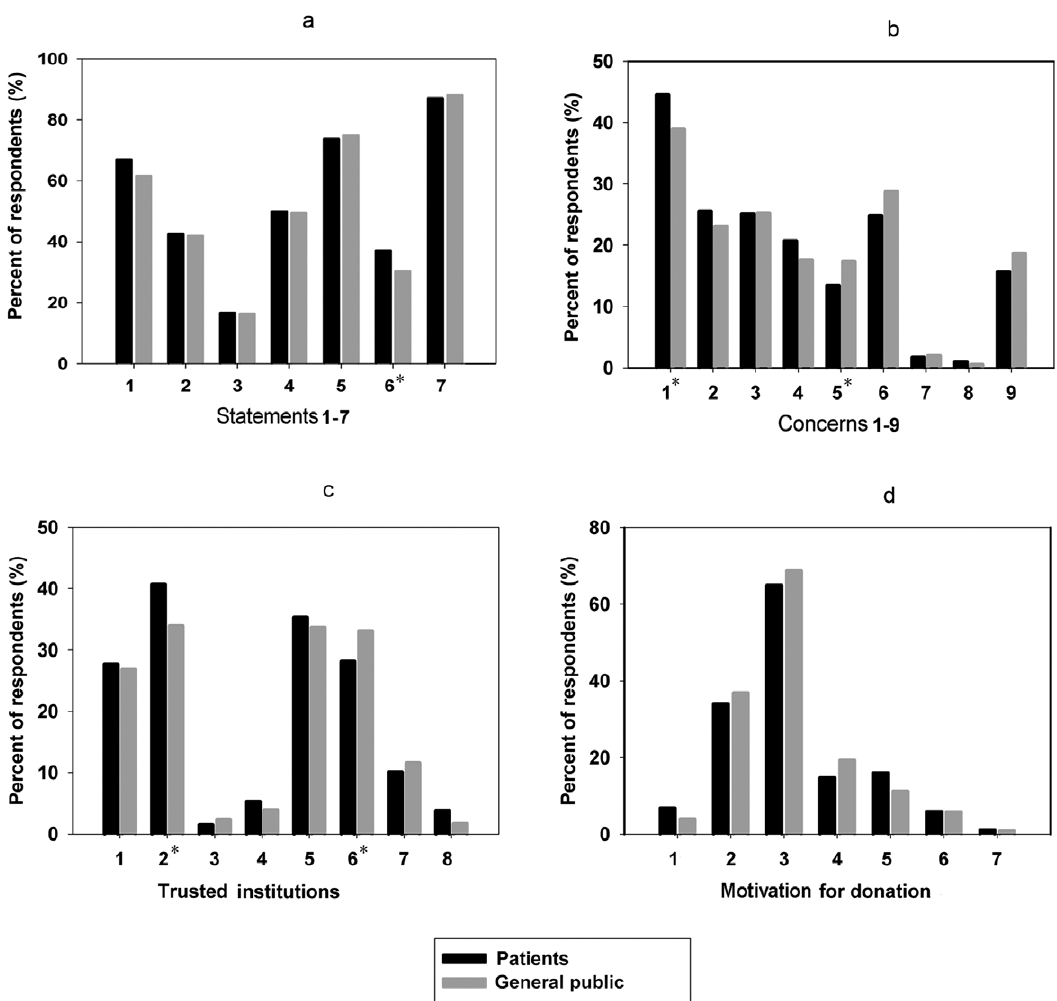
Figure 1. The results of x 2 -tests examining the differences in attitudes and perceptions between patients and general public members. *: P , 0.05. a. Statements 1–7: 1: I’m willing to donate the residual sample. 2: I trust medical institutions. 3: I would want to withdraw